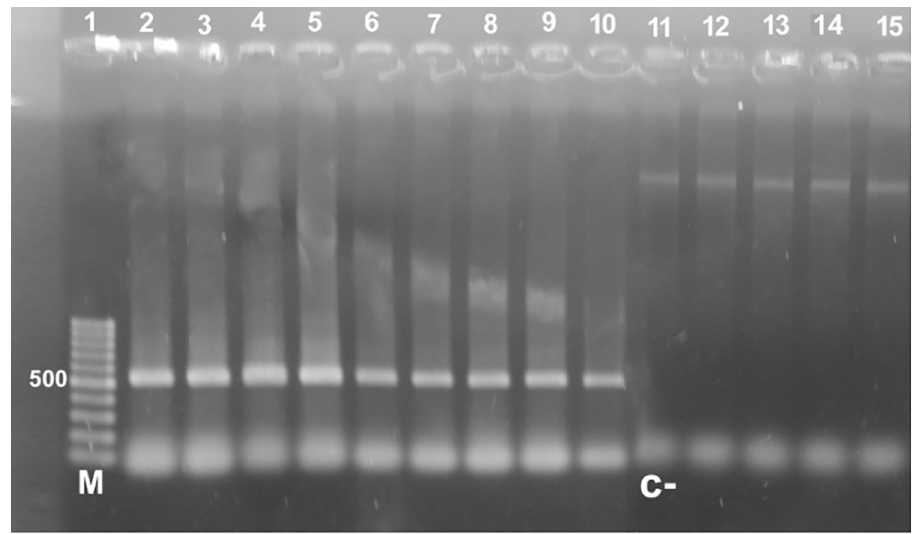
Fig 6. Agarose gel 1.5% stained with ethidium bromide showing the PCR products of 9 positive samples amplifying ASA.S1 region of Acanthamoeba using JDP1-2 primers showing a single band of 550 bp. in lanes (2– 10), lanes (12–15) are negative samples, lane 11 = negative control, and lane 1 (M) marker = 100 bp DNA